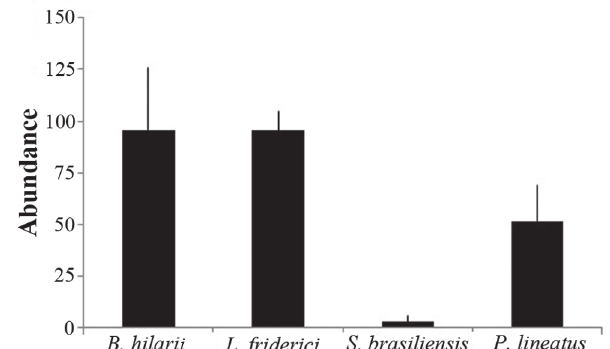
Fig. 4. Abundance of the main targets of Odontostilbe pequira . Mean number of individuals recorded in 10 x 12 m area censuses ± standard deviation. N = 10.